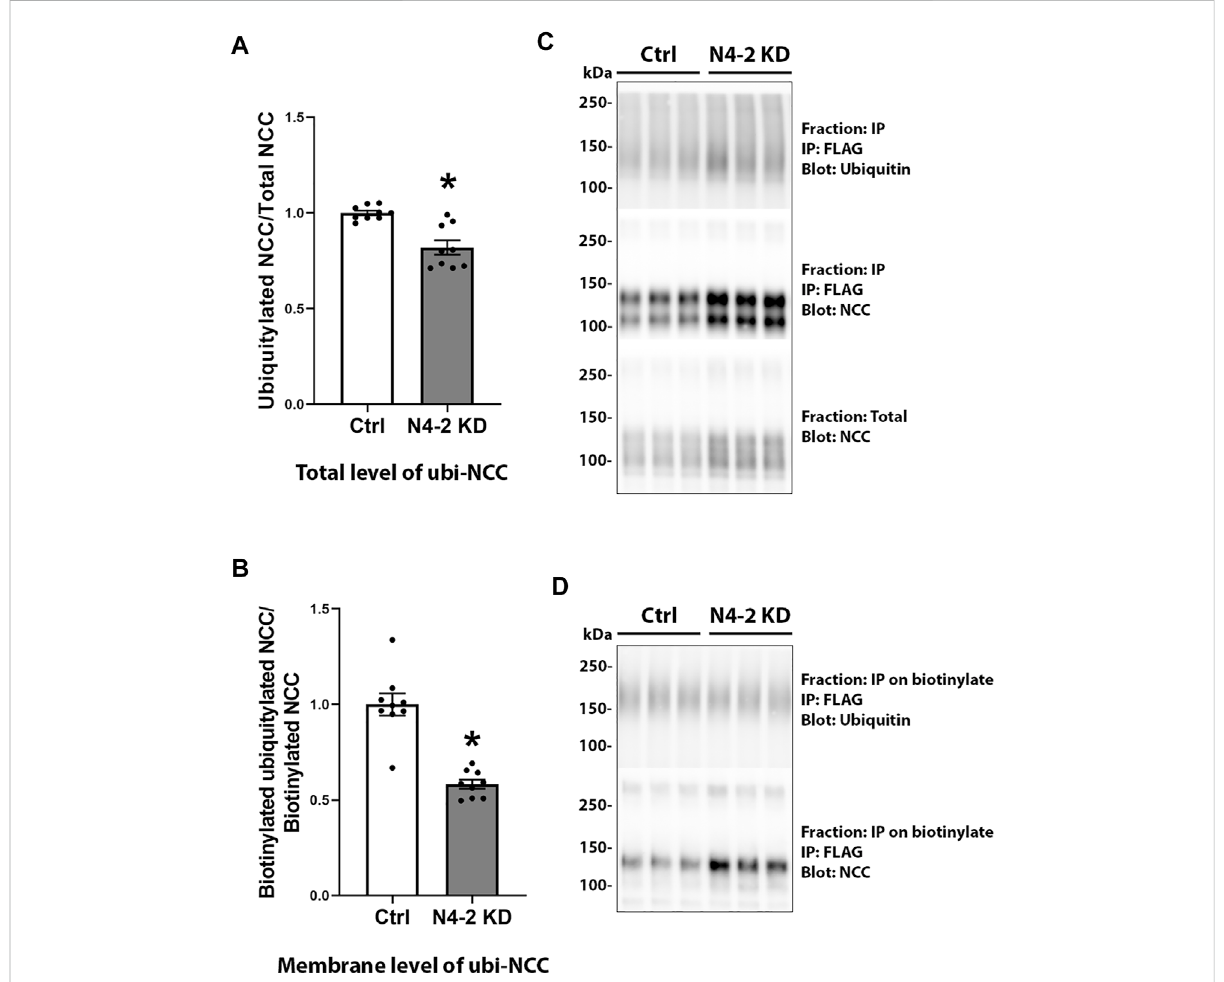
FIGURE 5 UbiquitylationlevelsofNCCintotallysatesandmembranefractionaredecreasedafterNedd4-2knockdown.Semi-quantitativeassessmentof ubiquitylation levels of NCC in total cell lysates (A) and membrane fractions (B) of MDCKI-hNCC Ctrl and Nedd4-2 (N4-2) KD cell lines. Data are means ± S.E.M. (n = 9) * p < 0.05 assessed by unpaired Student ’ s t-test. Representative immunoblots of ubiquitylated NCC and total NCC from total cell lysates are shown in (C) and the membrane fraction in (D)